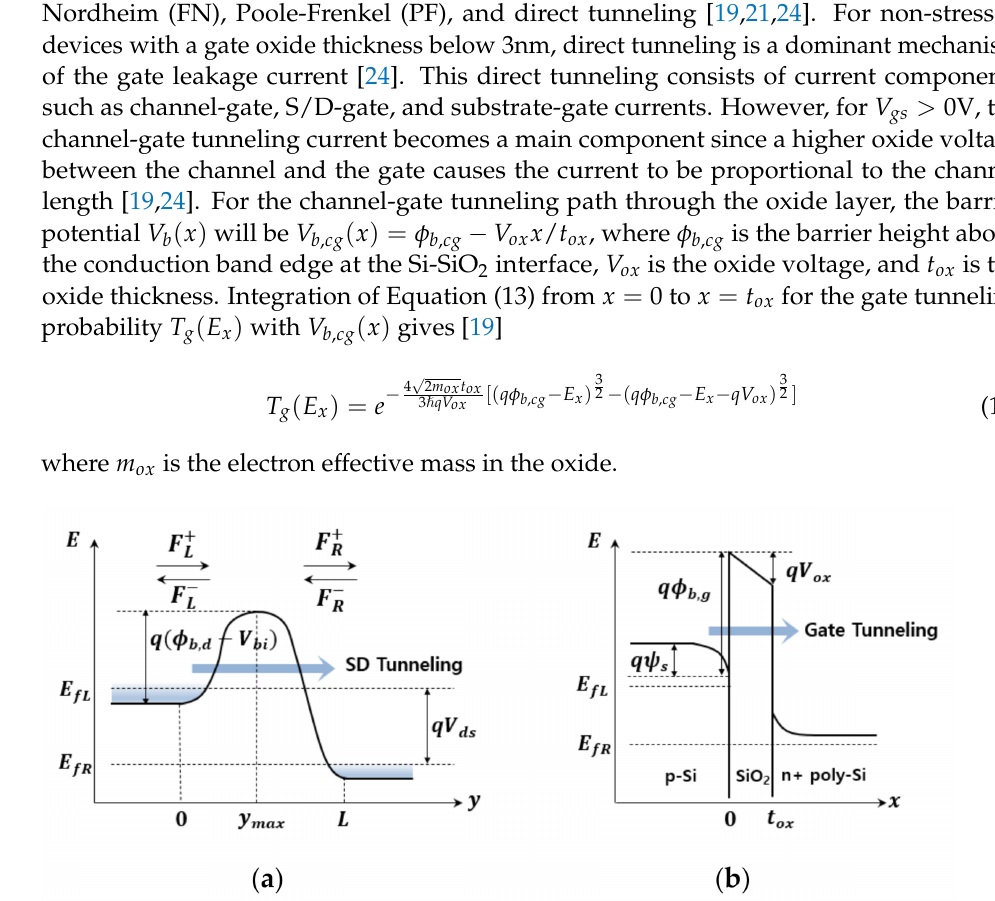
Figure 1. Representation of the energy barrier profile ( a ) along the y -axis in the source-drain direction and ( b ) along the x -axis in the channel-gate